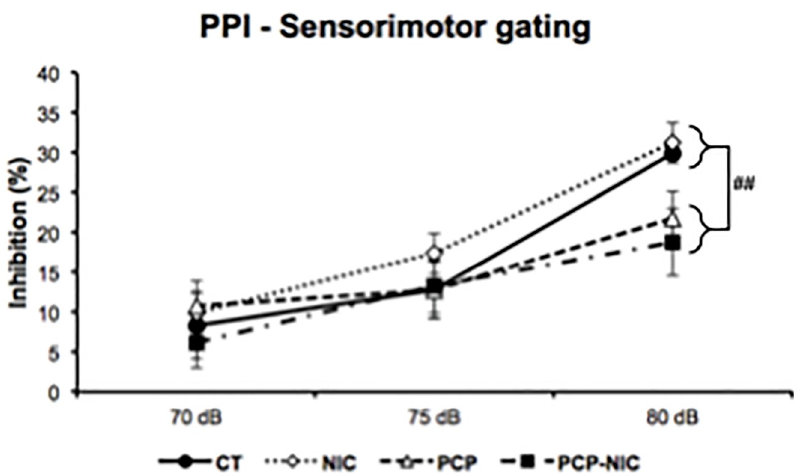
Fig 5. Effects of phencyclidine treatment, nicotine history and the combined insults, on prepulse inhibition of adolescent mice. CT: Control group ( ♀ = 12, ♂ = 16); NIC: Nicotine-exposed group ( ♀ = 14, ♂ = 14); PCP: Phencyclidine-treated group ( ♀ = 14, ♂ = 13); PCP-NIC: Phencyclidine-treated and nicotine-exposed group ( ♀ = 13, ♂ = 14). Values are means ± SEM. ## p < 0.01, phencyclidine-treated (PCP and PCP-NIC) vs . phencyclidine non-treated (CT and NIC) mice using the 80 dB